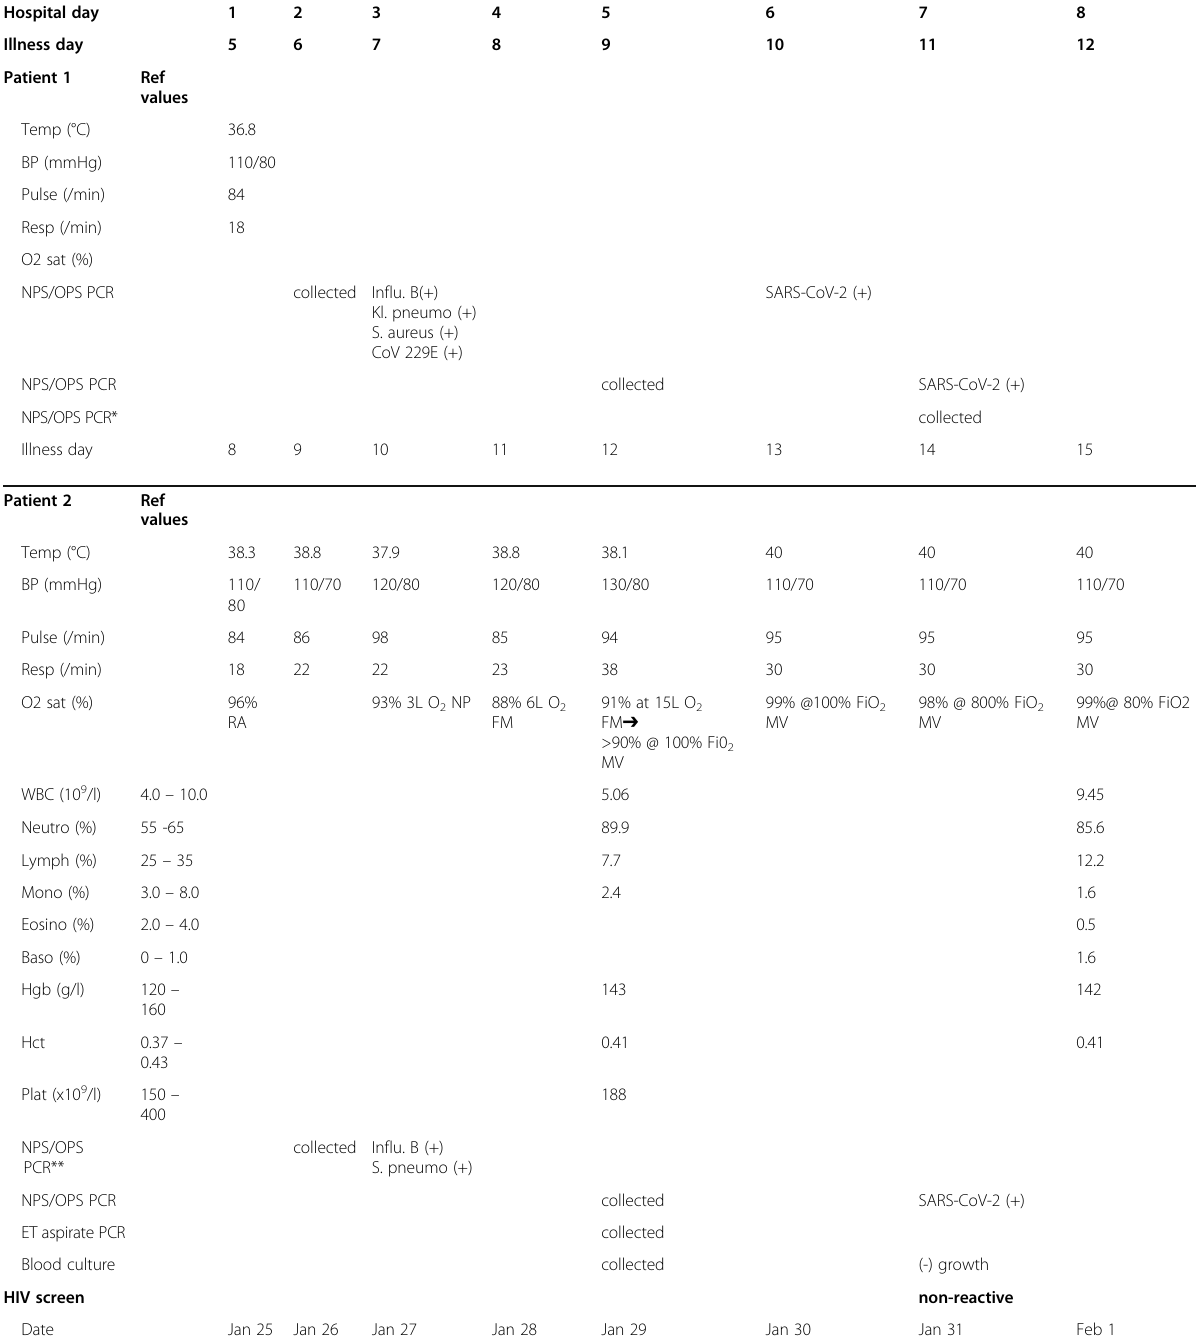
Table 1 Clinical laboratory results and vital